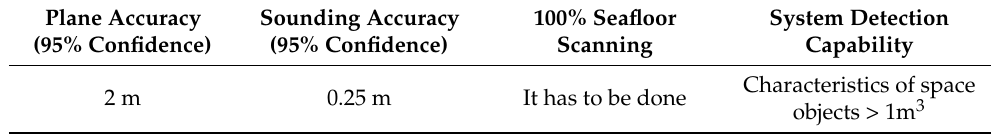
Table 4. Measurement accuracy.